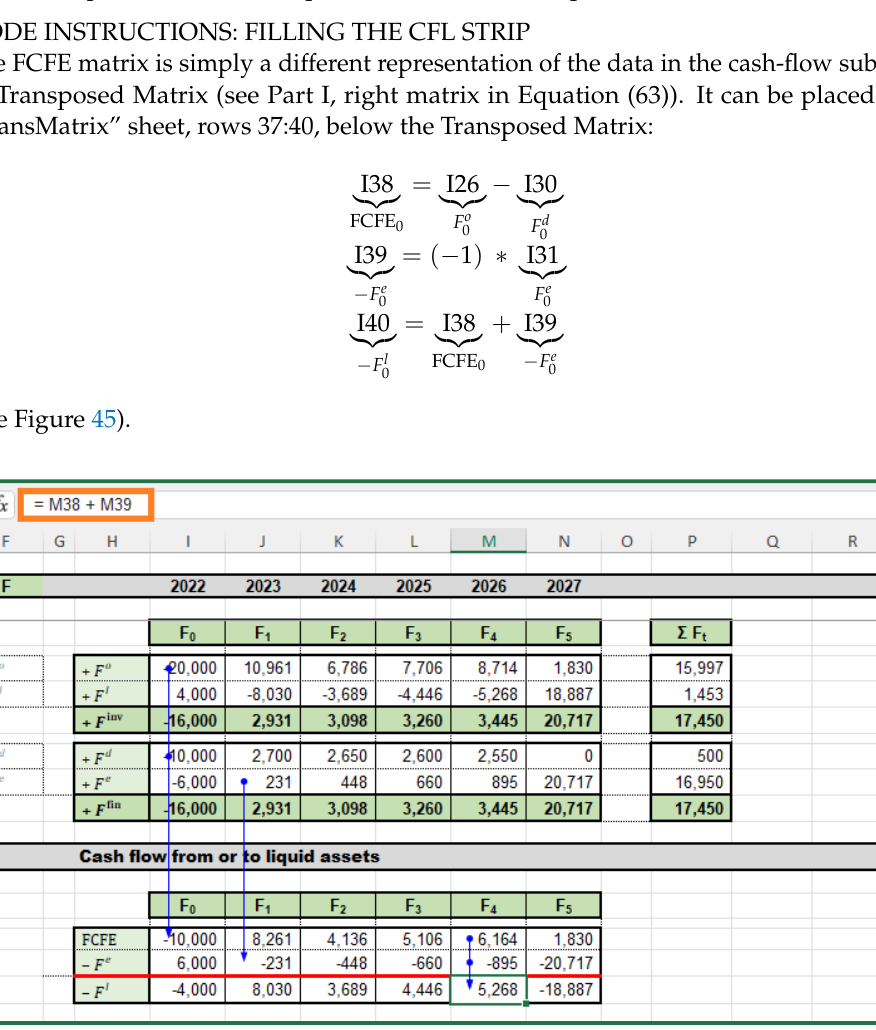
Figure 45. The FCFE at time 𝑡 = 4 (cell M38) is positive and equal to USD 6,164. Part of it is distrib- uted to the firm’s shareholders ( 𝐹 (cid:2872)(cid:3032) = USD 895), the remaining part is retained by the firm and re- invested in liquid assets ( −𝐹 (cid:2872)(cid:3039) = USD 5,268). This figure is necessary for calculating 𝐶 (cid:2872)(cid:3039) and, there- fore, completing the BS as of period 4. The CFE at time 𝑡 = 5 , when the project ends, is 𝐹 (cid:2873)(cid:3032) = USD 20,717, equal to the FCFE (USD 1,830) plus the end-of-period balance of liquid assets (USD